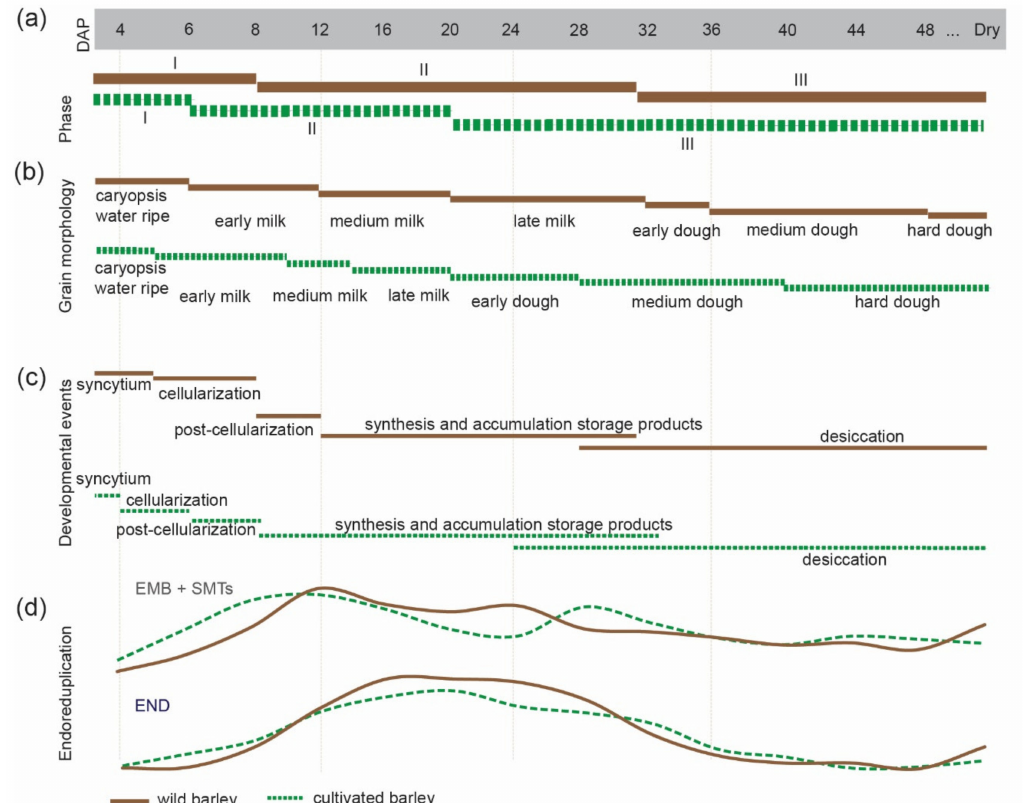
Figure 7. The model of phase transitions during wild (brown, solid lines) and cultivated barley [11] (green, dashed lines) seed development. Overview of ( a ) phase of barley grain development (based on [20,41], and ( b ) grain morphological changes (based on [12]), ( c ) developmental events (based on [20,41,42] and ( d ) endoreduplication dynamics. EMB + SMTs = embryo and seed maternal tissues and END =